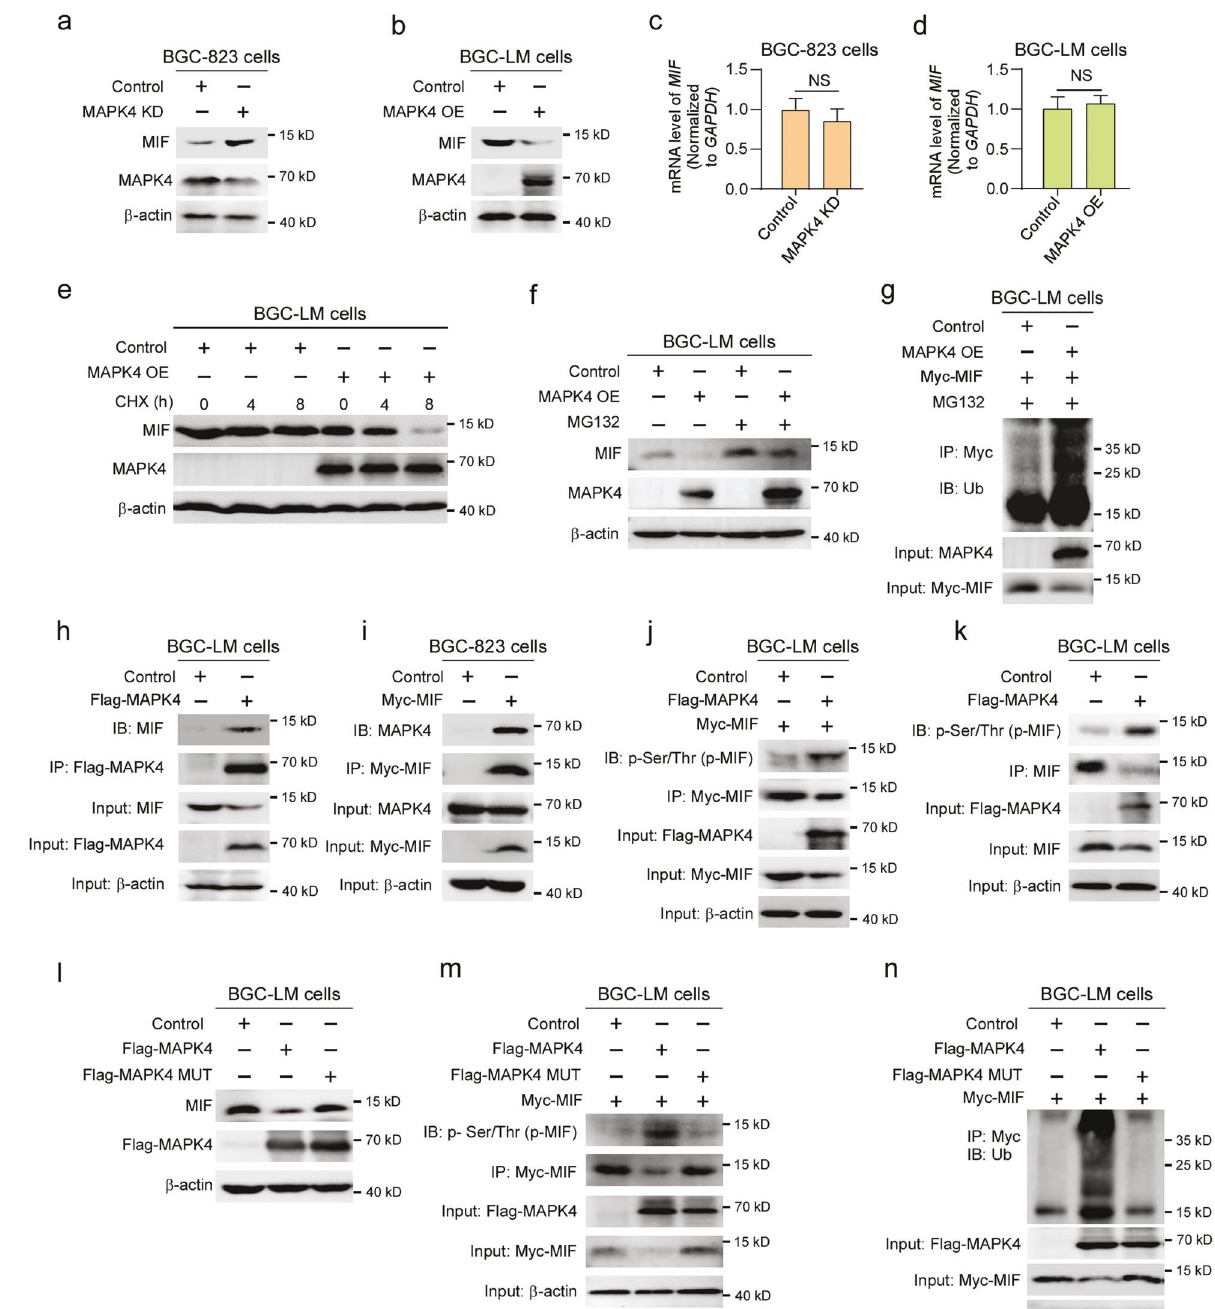
Fig. 6 MAPK4 promotes MIF degradation in gastric cancer cells. a Western blot analysis of MIF in control and MAPK4-depleted BGC-823 cells. b Western blot analysis of MIF in control and MAPK4-overexpressing BGC-LM cells. c Quantitative RT-PCR analysis of MIF mRNA in control and MAPK4-depleted BGC-823 cells. d Quantitative RT-PCR analysis of MIF mRNA in control and MAPK4-overexpressing BGC-LM cells. e , f BGC- LM cells, infected or not infected with pLVX-MAPK4 lentivirus were treated with cycloheximide for the indicated times or MG132 and used for western blot analysis. g Control and MAPK4-overexpressing BGC-LM cells were transfected with the Myc-MIF vector, treated with MG132, and subjected to immunoprecipitation analysis with anti-Myc antibody. h BGC-LM cells transfected with control or Flag-MAPK4 vector were used for immunoprecipitation analysis with anti-FLAG antibody. i BGC-823 cells were transfected with control or Myc-MIF vector and subjected to immunoprecipitation analysis with anti-Myc antibody. j BGC-LM cells transfected with the indicated vectors were subjected to immunoprecipitation analysis with anti-Myc antibody. k BGC-LM cells were transfected or not transfected with Flag-MAPK4 and subjected to immunoprecipitation analysis with an anti-MIF antibody. l BGC-LM cells transfected with the indicated vectors were used for western blotting. m , n BGC-LM cells were transfected with the indicated vectors and subjected to immunoprecipitation analysis with anti-Myc antibody. The data are expressed as the means ± standard deviations. NS not signi fi cant (Student ’ s t